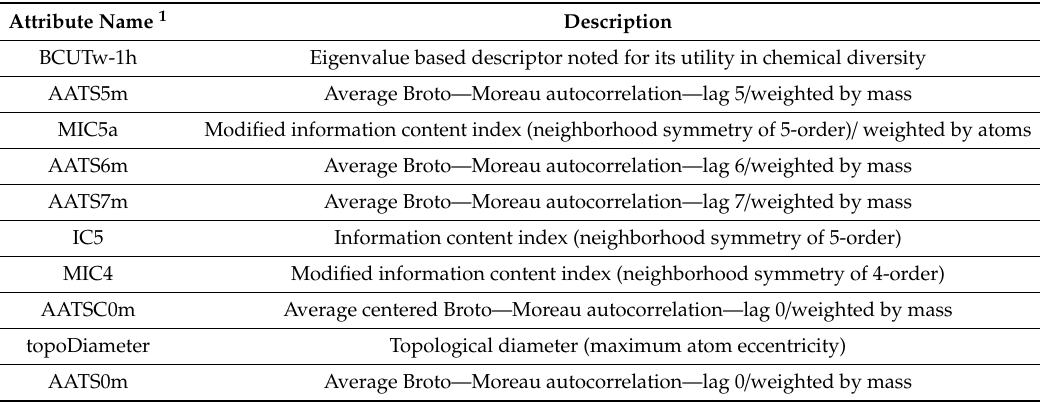
Table 2. Top 10 features for the best model (random forest) during